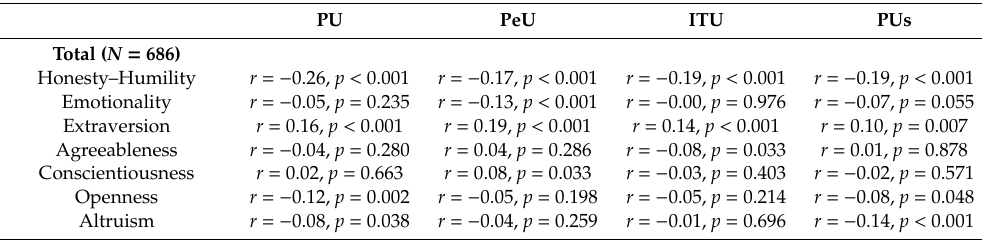
Table A1. Partial Pearson correlations (corrected for age) between the HEXACO-PI-R scales and the scales assessing TA with regard to smartphone use for business purposes.